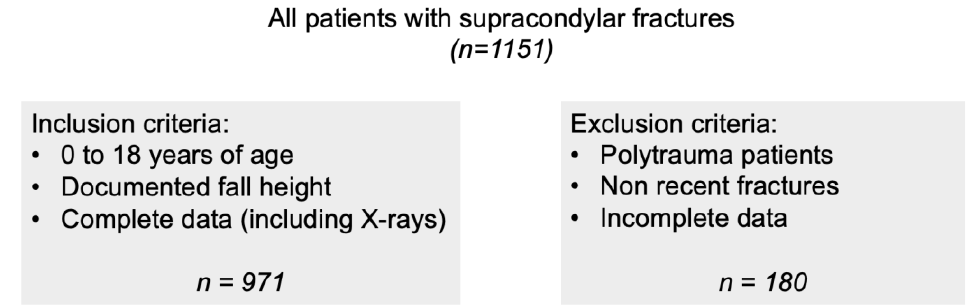
Figure 1. Inclusion and exclusion criteria .